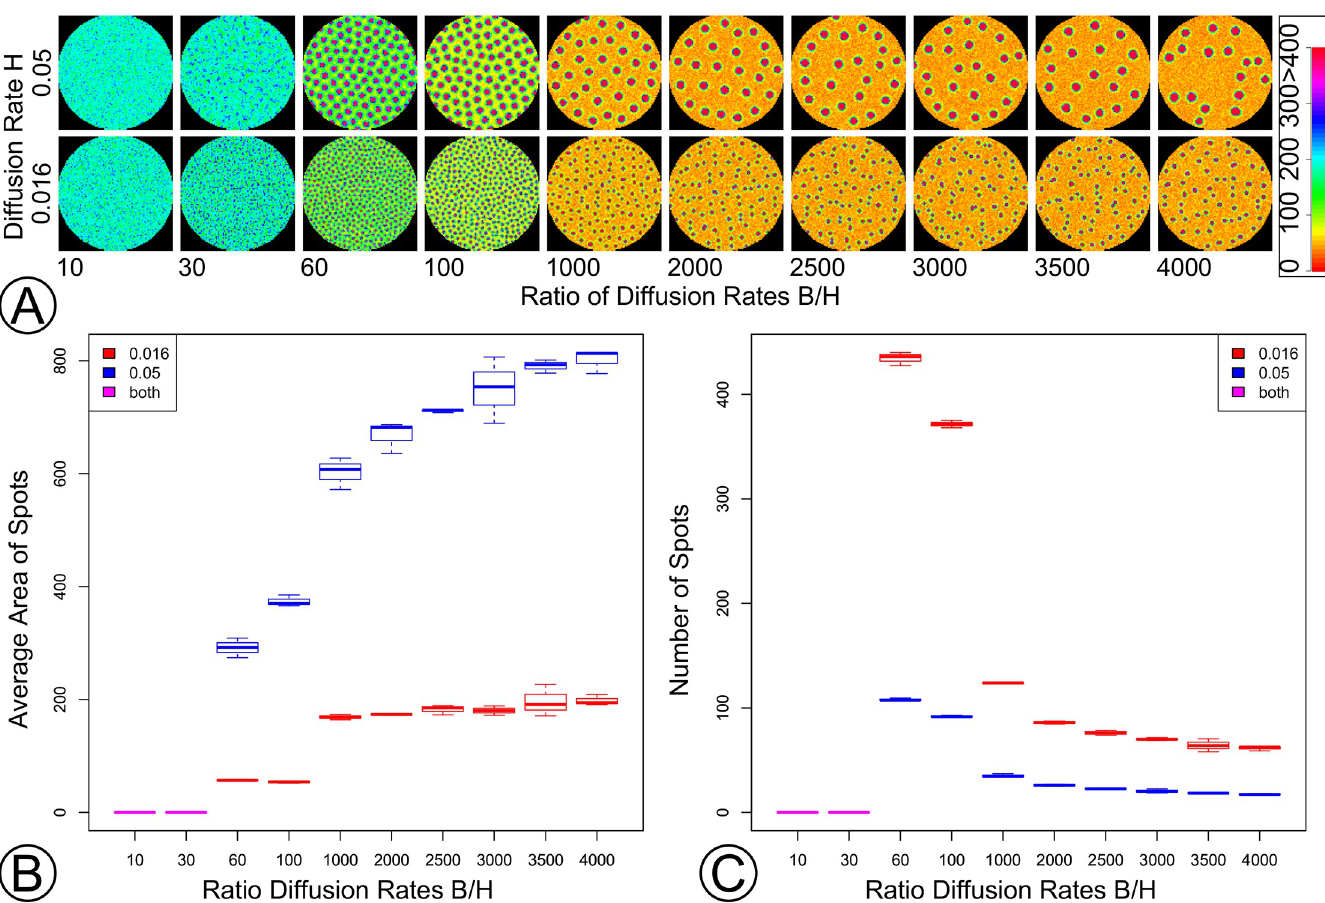
Fig 5. Density and size of supplemental vascular bundles varies with diffusion rates of H and B . (A) [ H ] for various diffusion rates of H ( y -axis) and ratio of diffusion rates of B and H ( D / D ) ( x -axis). Legend shows mapping between [ H ] and color (Black represents no molecules). (B) Diameter of regions of high [ H ] ( > 400 molecules B H per voxel) as a function of D B / D H . (C) Number of regions of high [ H ] as a function of D B / D H . Legends for (B) and (C) show color coding for diffusion rates of H . Note that x -axes are not to scale in (B) and (C). Box plots are based on 3 simulation replicates of each parameter combination. S10 and S11 Movies provide example animations of H diffusion rate at 0.05 and ratios at 10 and 1000,